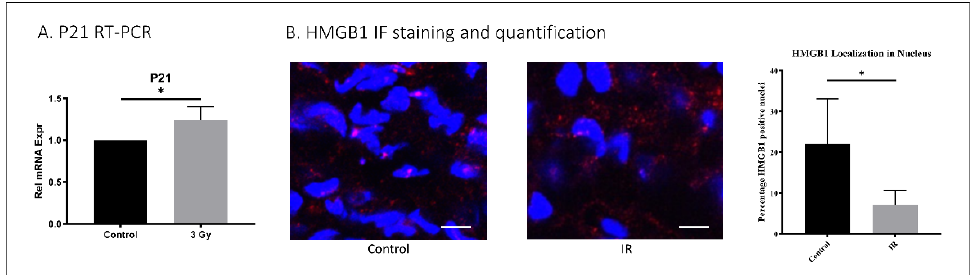
Figure 4. IR whole-body exposure induces disc cellular senescence in mice. ( A ) Whole-disc tissue p21 gene expression was increased in IR-treated mice compared to untreated control. ( B ) HMGB1 immunofluorescence staining (red) and quantification of nucleus (blue, DAPI) localization revealed decreased nuclear expression of HMGB1 in disc tissue of IR-treated compared to untreated mice. Data shown as an average of n = 5 with one standard deviation. On microscopic images, the white bar for scale measures 20 μ m. * p ≤ 0.05.